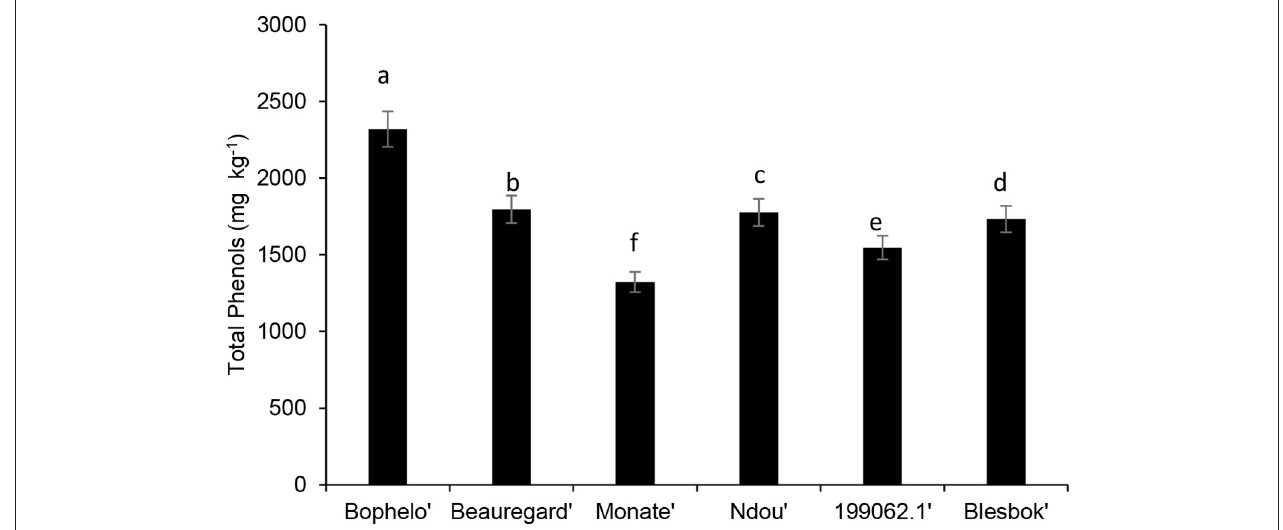
FIGURE 2 | Comparison of the total phenolic content in the leaves of different South African sweet potato cultivar with the USA variety Beauregard and the Peruvian cultivar 199062.1. Bars with similar alphabetic letter are not significantly different at p < 0.05 according to Fisher’s LSD test.